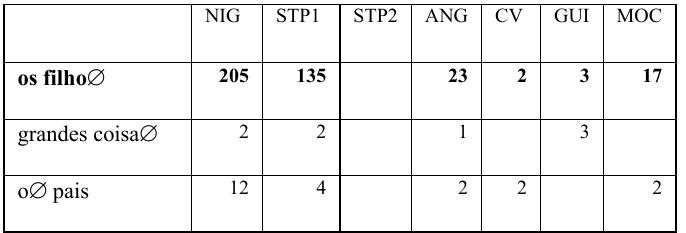
Table 5: Patterns of defective number agreement